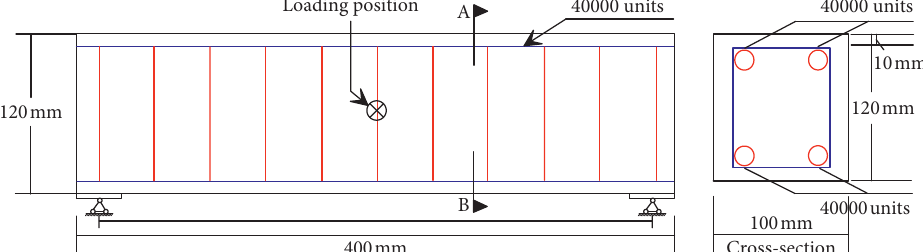
Figure 1: Metal material model and unit division for simulation and analysis of solid-state processing.